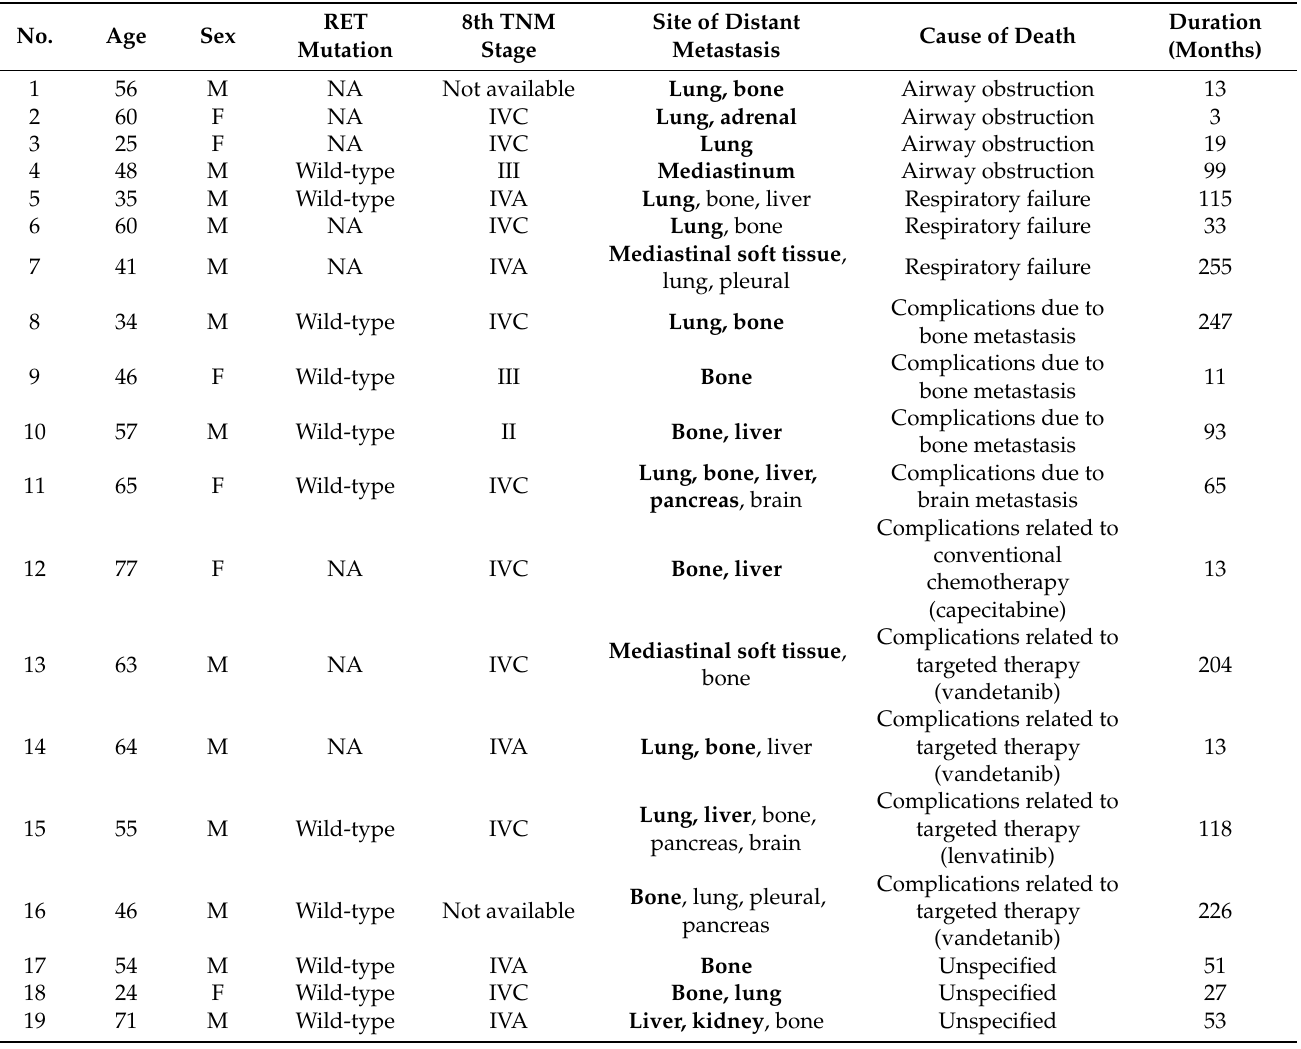
Table 5. Detailed information of 19 deceased